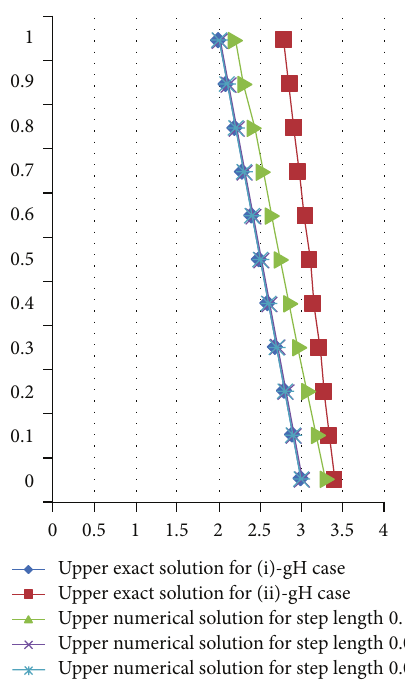
Figure 4: Comparison of upper exact solutions and numerical solution for different step lengths at 𝑡 = 0.4